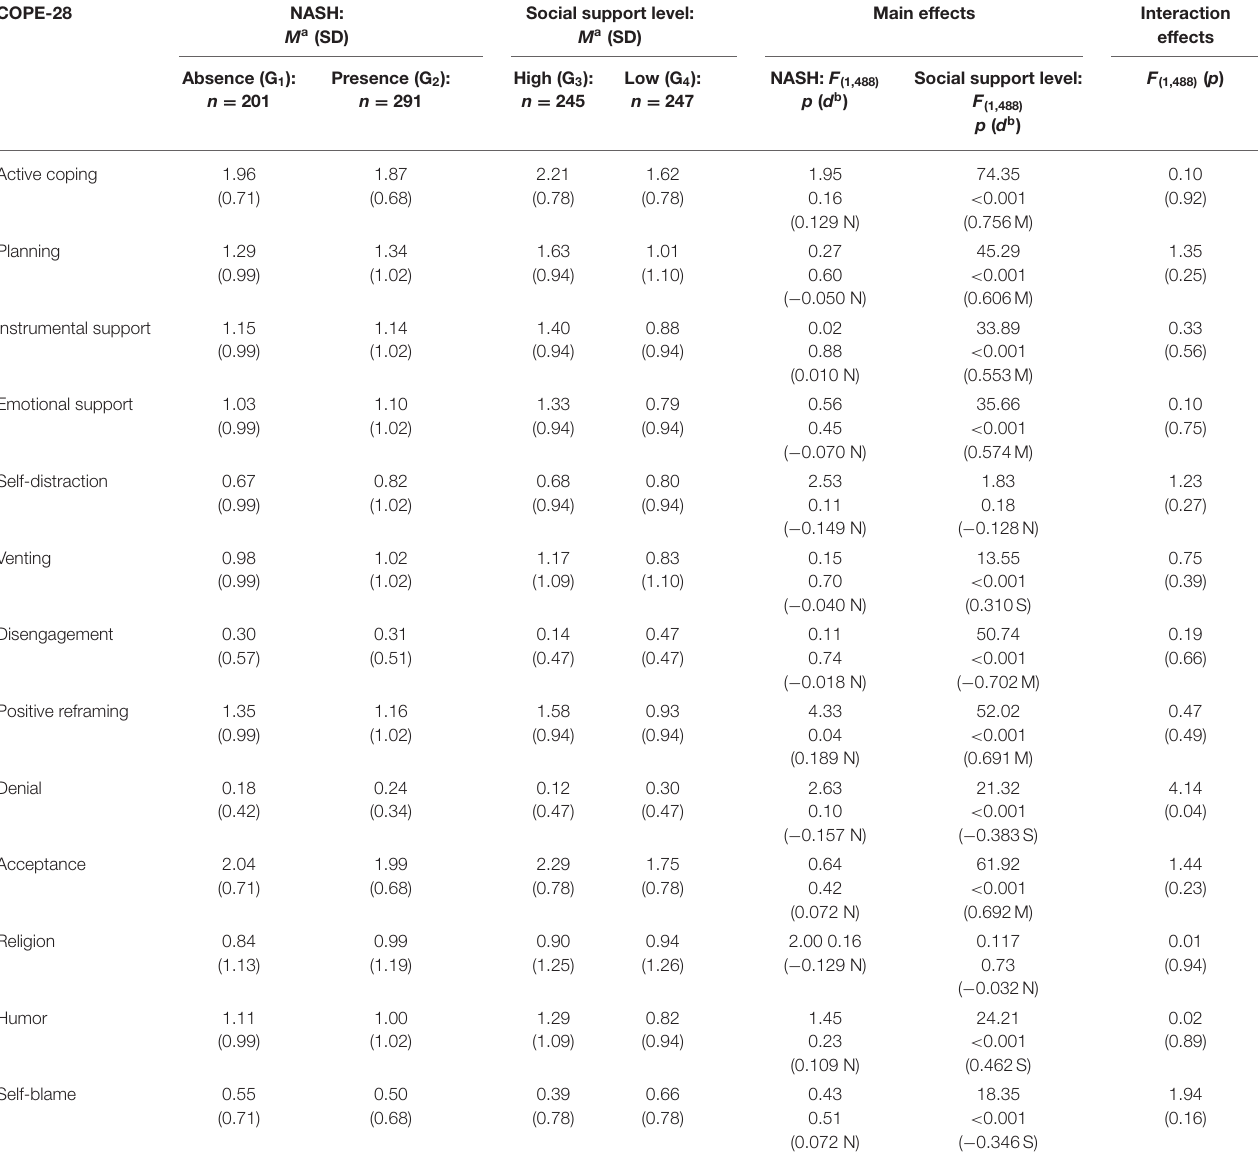
TABLE 4 | Coping strategies (COPE-28) of non-alcoholic fatty liver disease (NAFLD) patients based on non-alcoholic steatohepatitis (NASH; absence and presence) and social support level (high and low) variables.